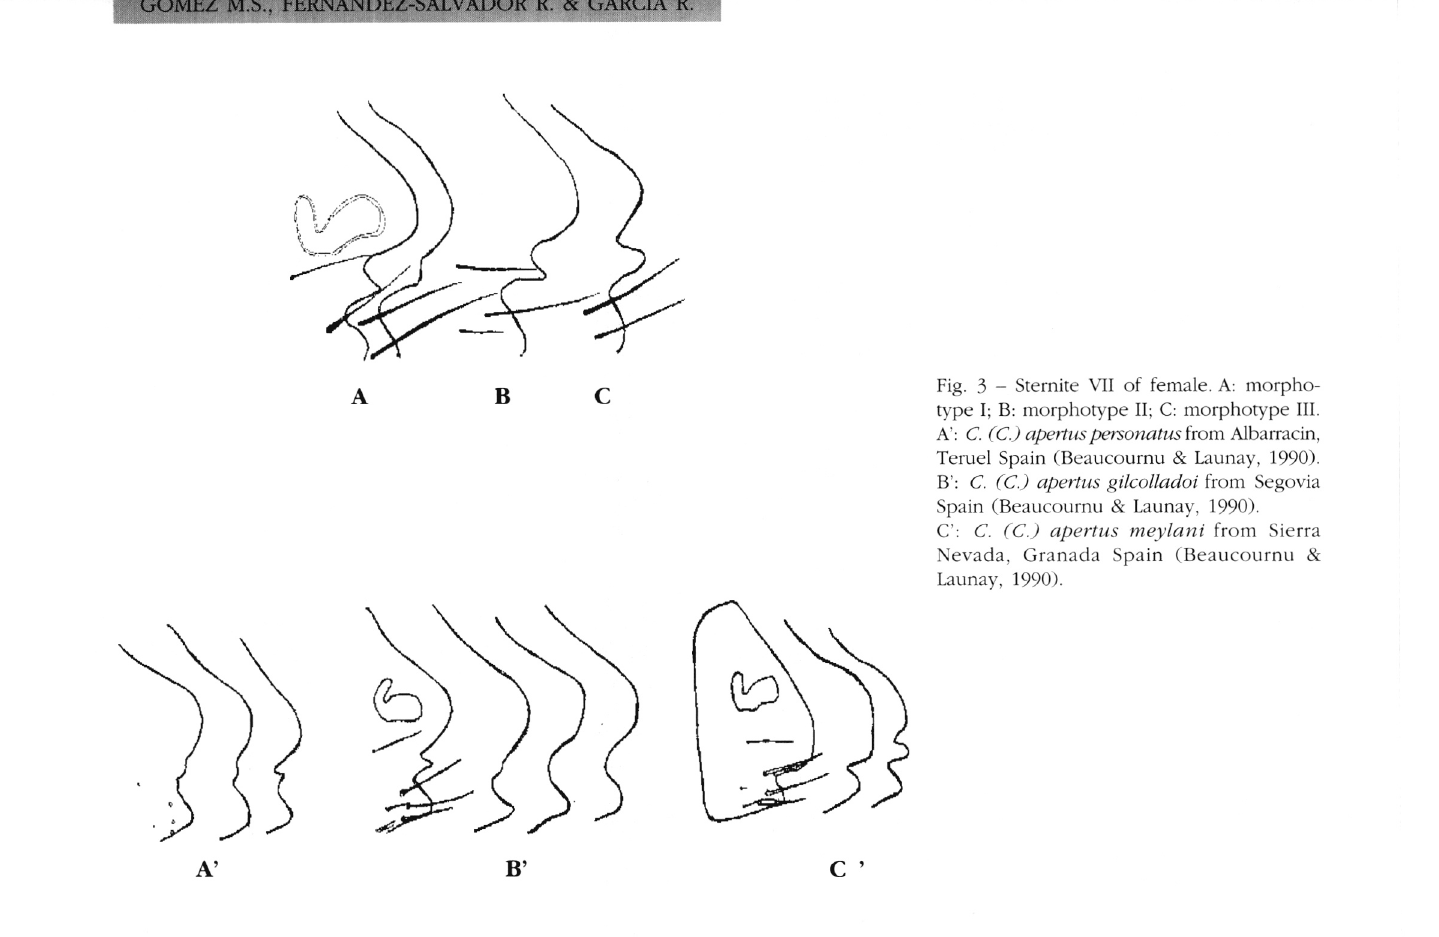
Fig. 3 - Sternite VII of female. A: morpho­ type I; B: morphotype II; C: morphotype III. A’: C. (C.) apertus personatus from Albarracin, Teruel Spain (Beaucournu & Launay, 1990). B’: C. (C.) apertus gilcolladoi from Segovia Spain (Beaucournu & Launay, 1990). C’: C. (C.) apertus meylani from Sierra Nevada, Granada Spain (Beaucournu & Launay,